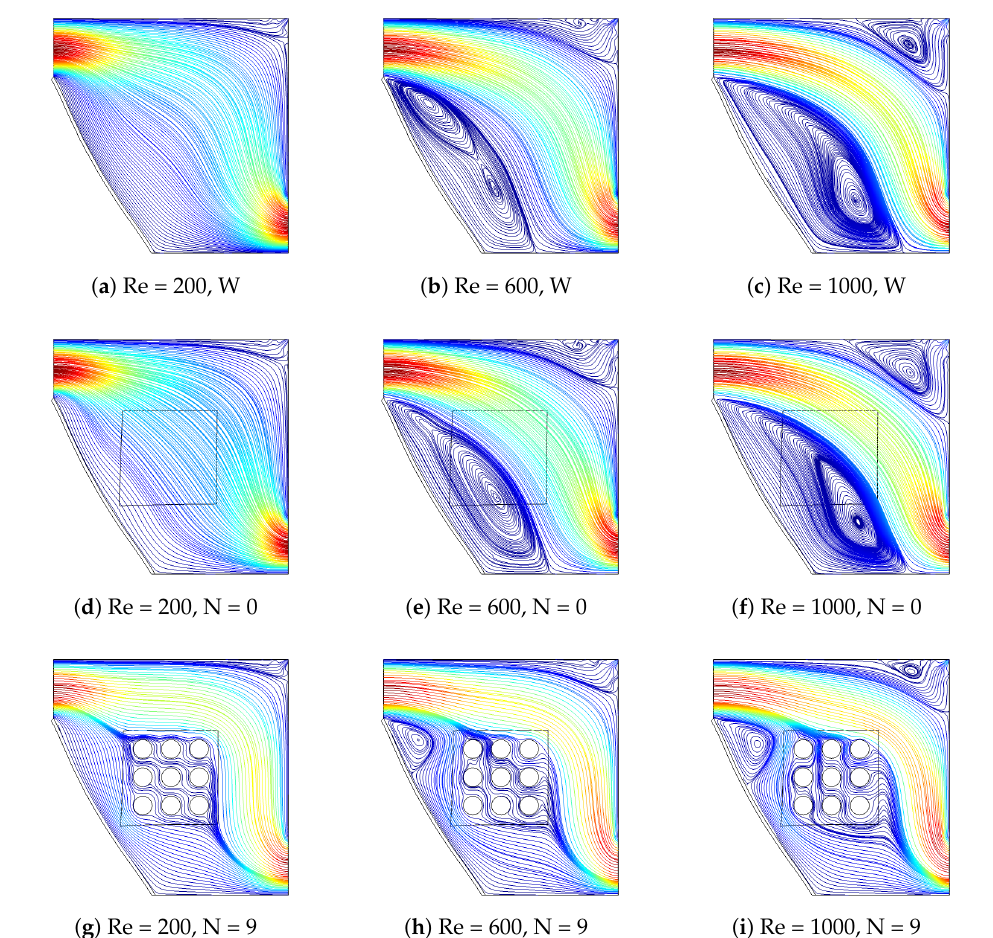
Figure 6. Impacts of Re on the streamline variations for different cases of using PPs (Ha = 15, Ca = 10 − 5 , Da = 10 − 2 ).